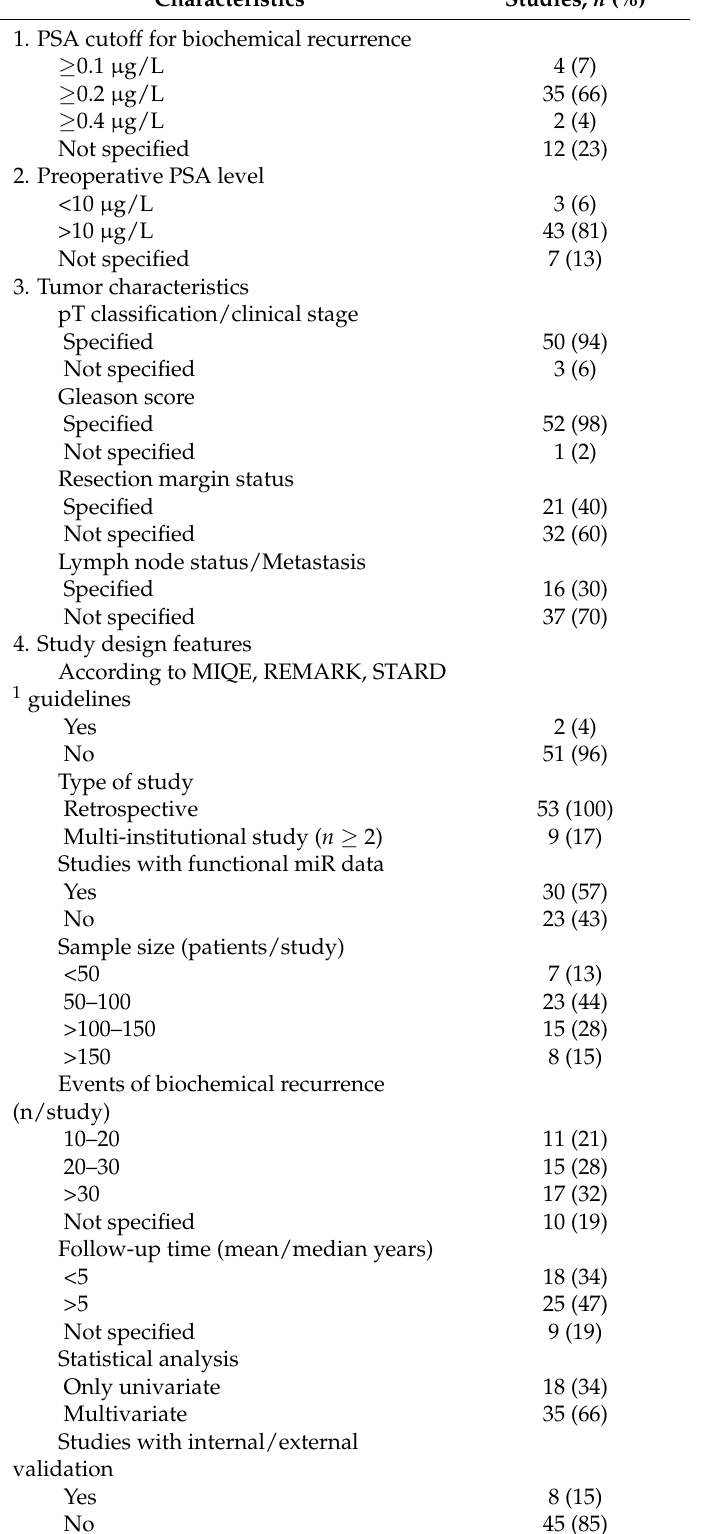
Table 5. Characteristics of the 53 studies evaluated in this